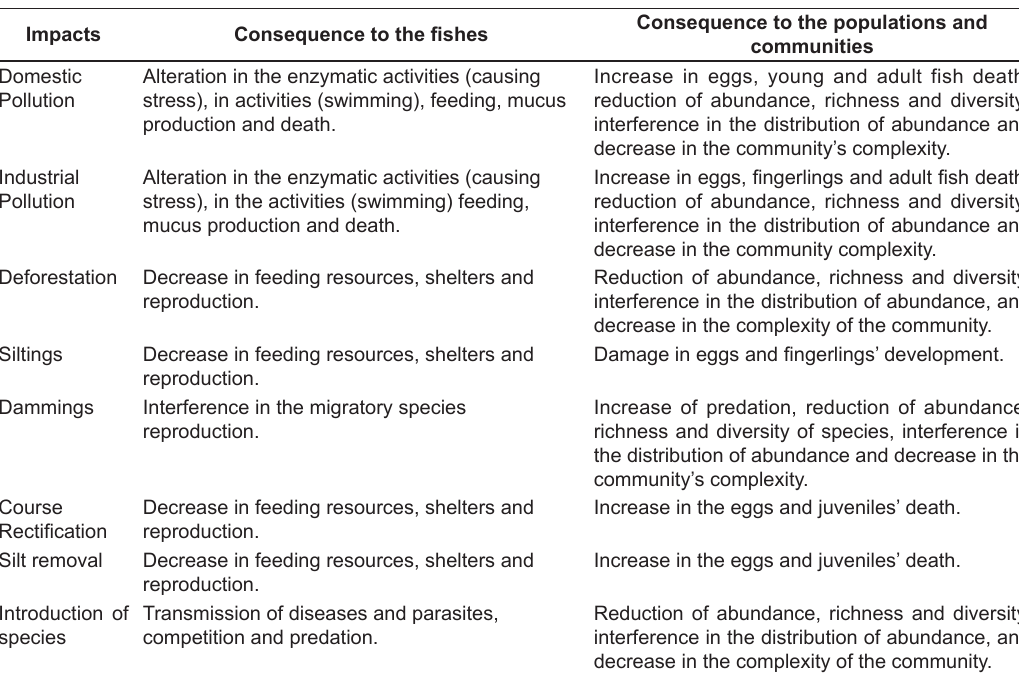
Consequence to the populations and communities